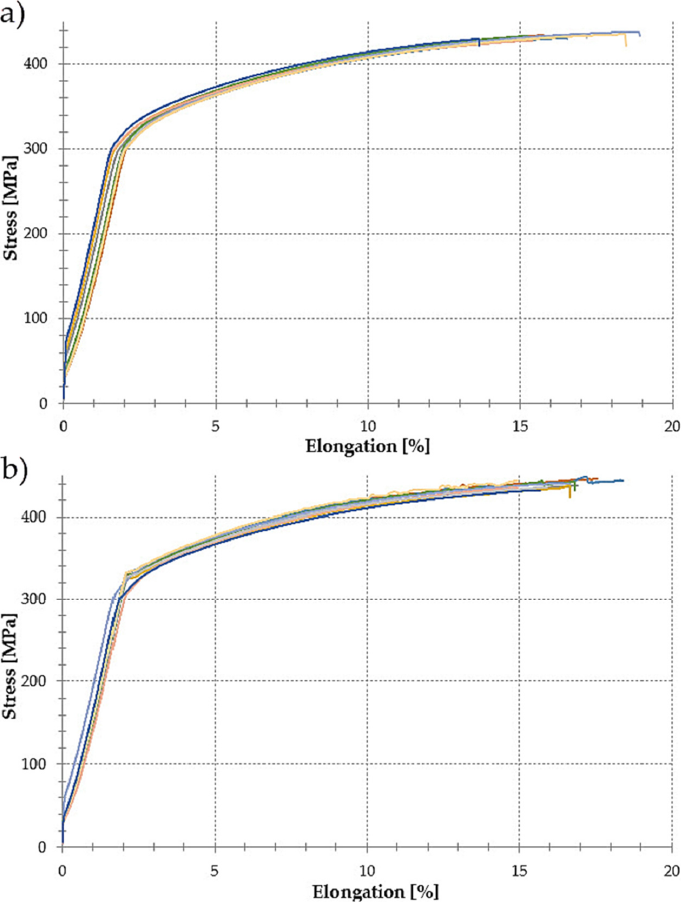
Figure 4. Material characteristics of the EN AW-2024 T351 alloy obtained for samples with a thickness